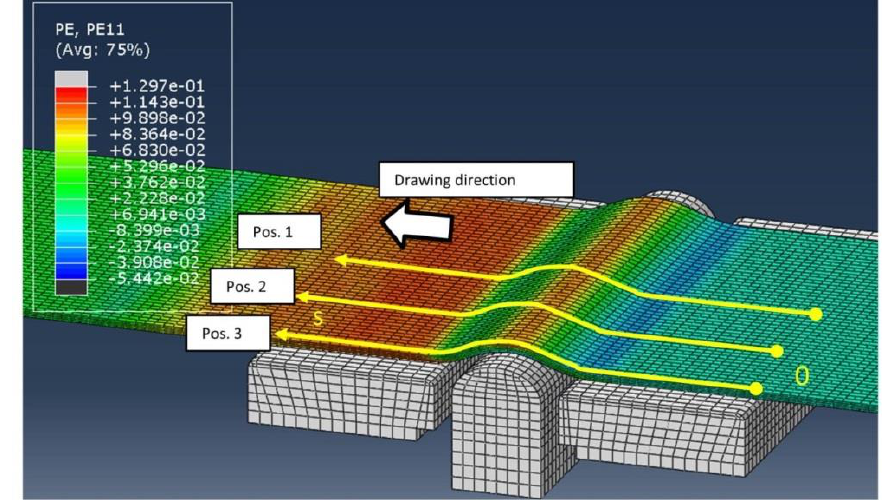
Figure 22. The evaluated paths for strain distribution on the sheet metal.